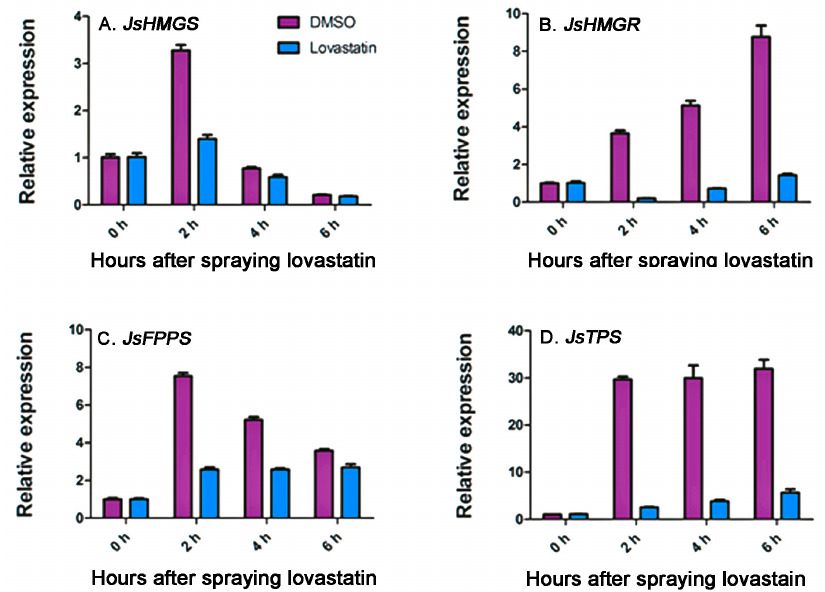
Figure 6. qRT-PCR analysis of JsHMGS ( A ); JsHMGR ( B ); JsFPPS ( C ); and JsTPS ( D ) expressions in J. sambac ‘Bifoliatum’ flowers immediately after being sprayed with 50 μ m/L lovastatin or dimethyl sulfoxide (DMSO) to 6 h, thereafter. The expression levels were normalized based on the expression of